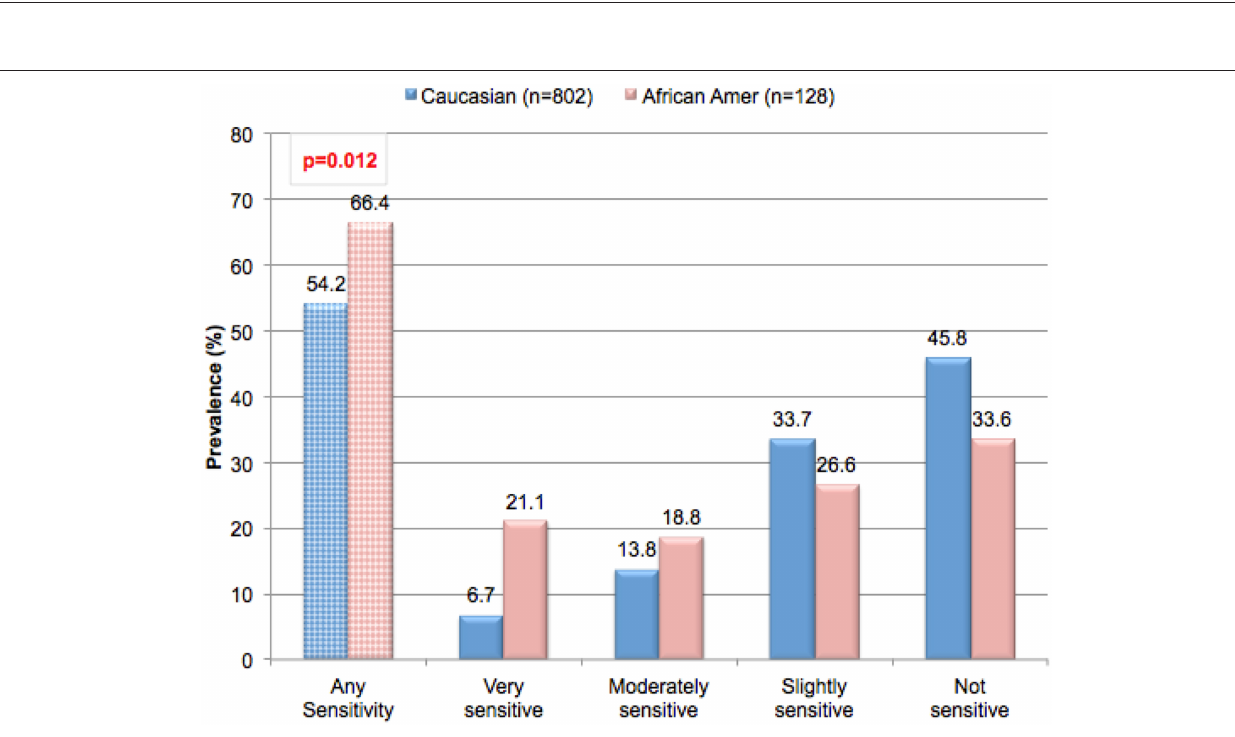
Frontiers in Medicine |